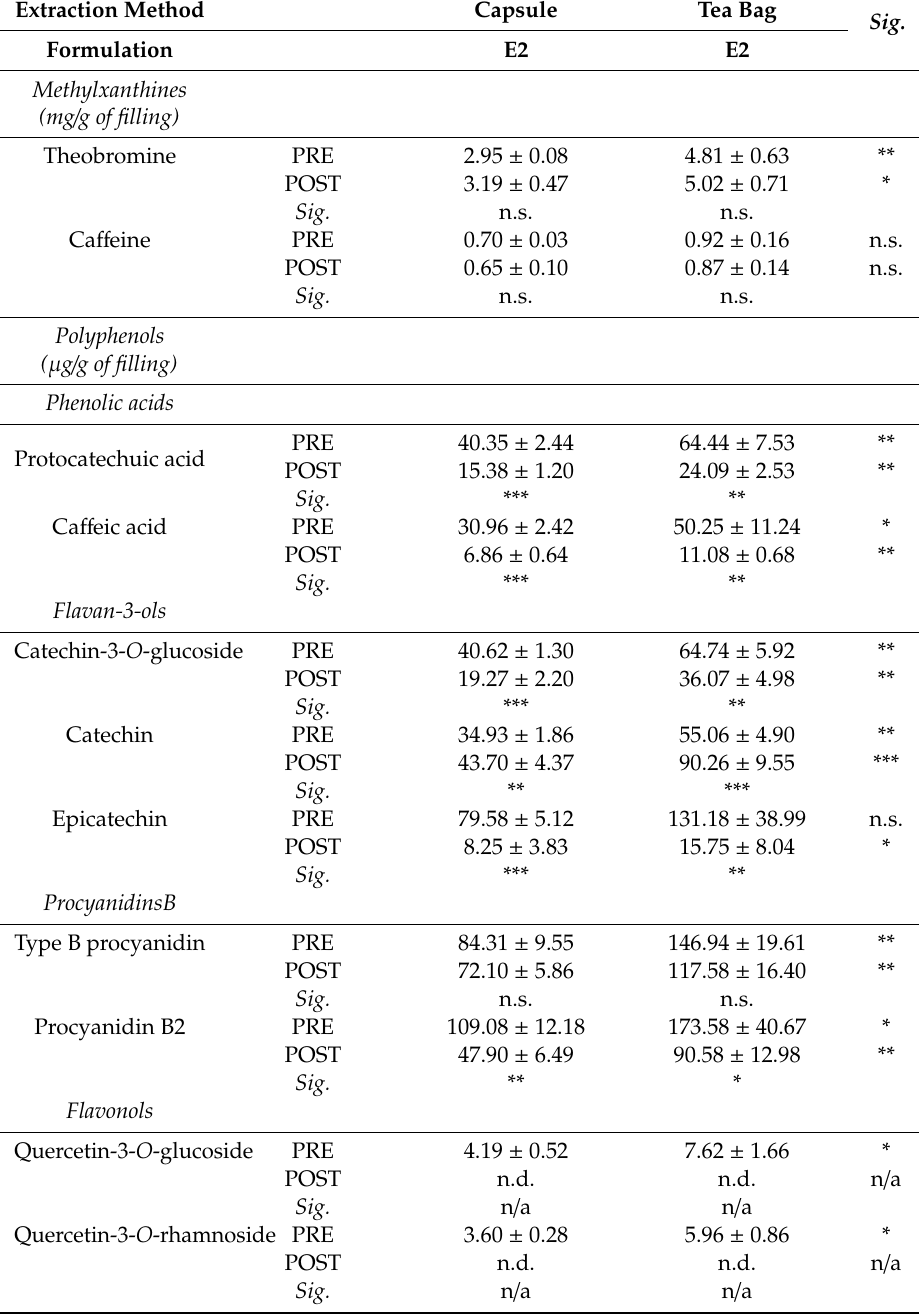
Table 5. Values (mean ± standard deviation) after normalization of methylxanthines and identified polyphenols before (PRE) and after (POST) in vitro gastrointestinal digestion for capsule and tea bag coconut flavored beverages (E2) and results of ANOVA. Significance is reported for each compound between PRE- and POST-in vitro gastrointestinal digestion within the same extraction technique (column) and for each compound both PRE- and POST-in vitro gastrointestinal digestion between the two extraction methods